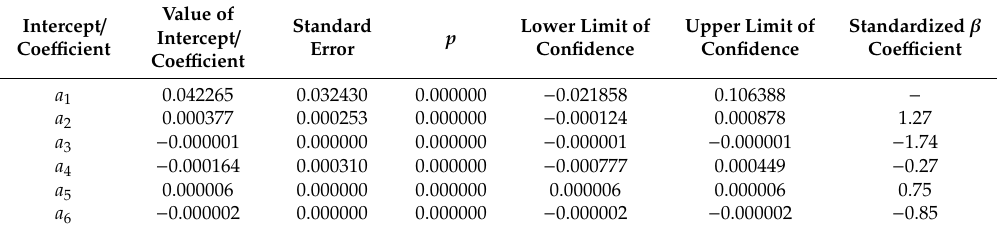
Table 10. Statistical evaluation of H content model of torrefied pruned biomass.